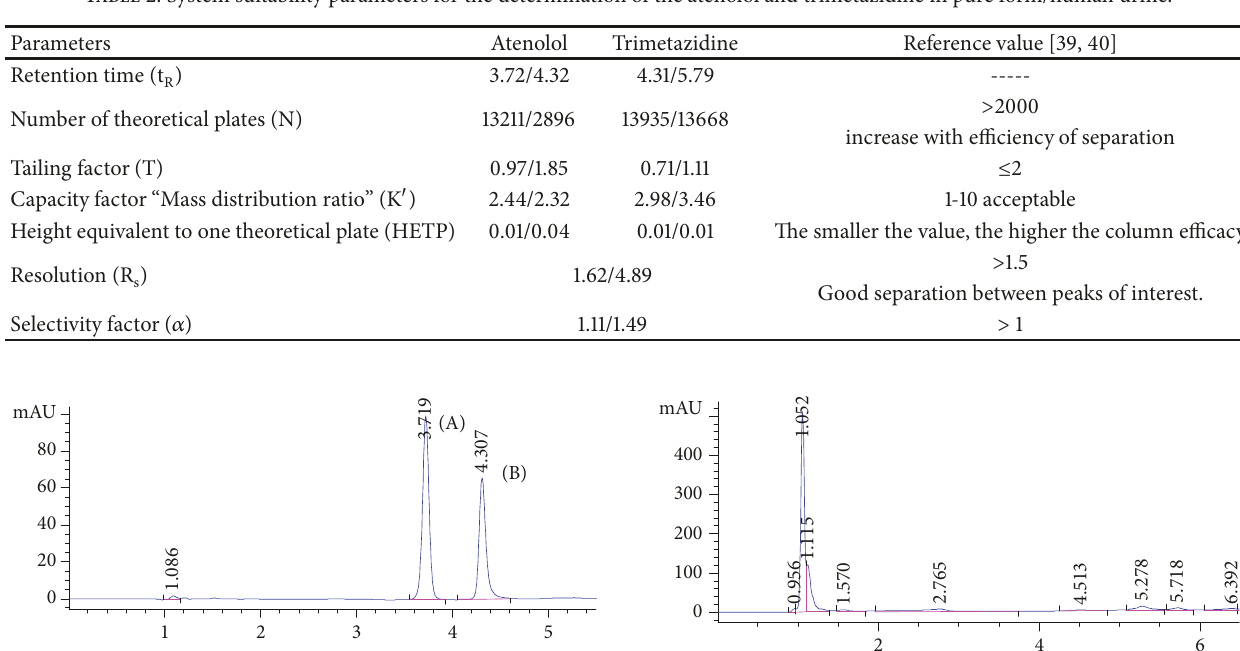
Table 2: System suitability parameters for the determination of the atenolol and trimetazidine in pure form/human urine.